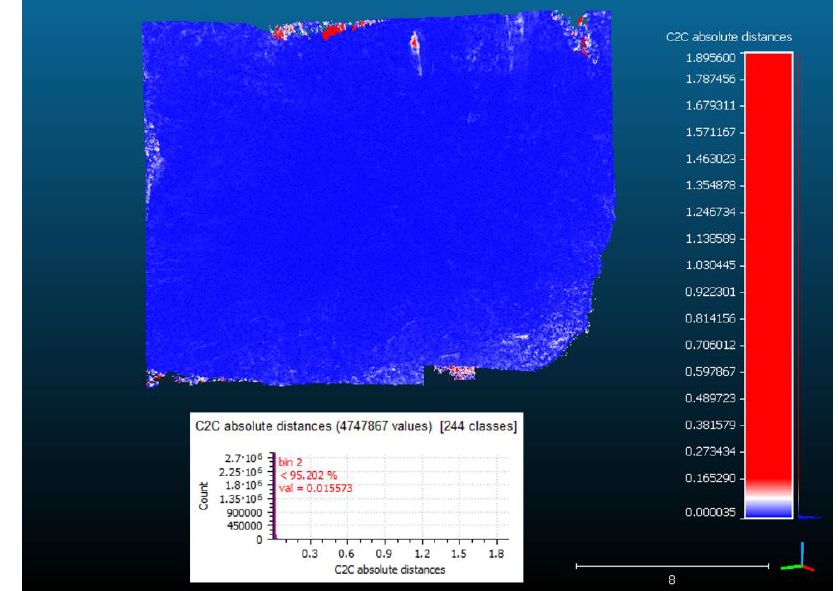
Figure 5: Cloud-to-cloud distance comparison between multispectral and TLS